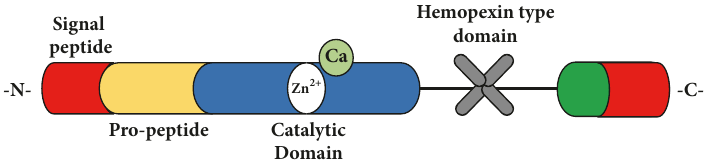
Figure 3: Basic structure o f t h e MMP . MMPs consist of four main domains: a signal peptide that directs the secretion of the protein to the outside of the cell, a propeptide region that keeps the enzyme inactive until it is proteolytically cleaved, a catalytic domain that contains zinc and calcium and to which the cysteine of the propeptide region binds to keep it inactive (cysteine switch), and a hemopexin-like domain that mediates substrate specificity and interactions with endogenous inhibitors. MMP-2 and MMP-9 possess a fibronectin-type domain for matrix